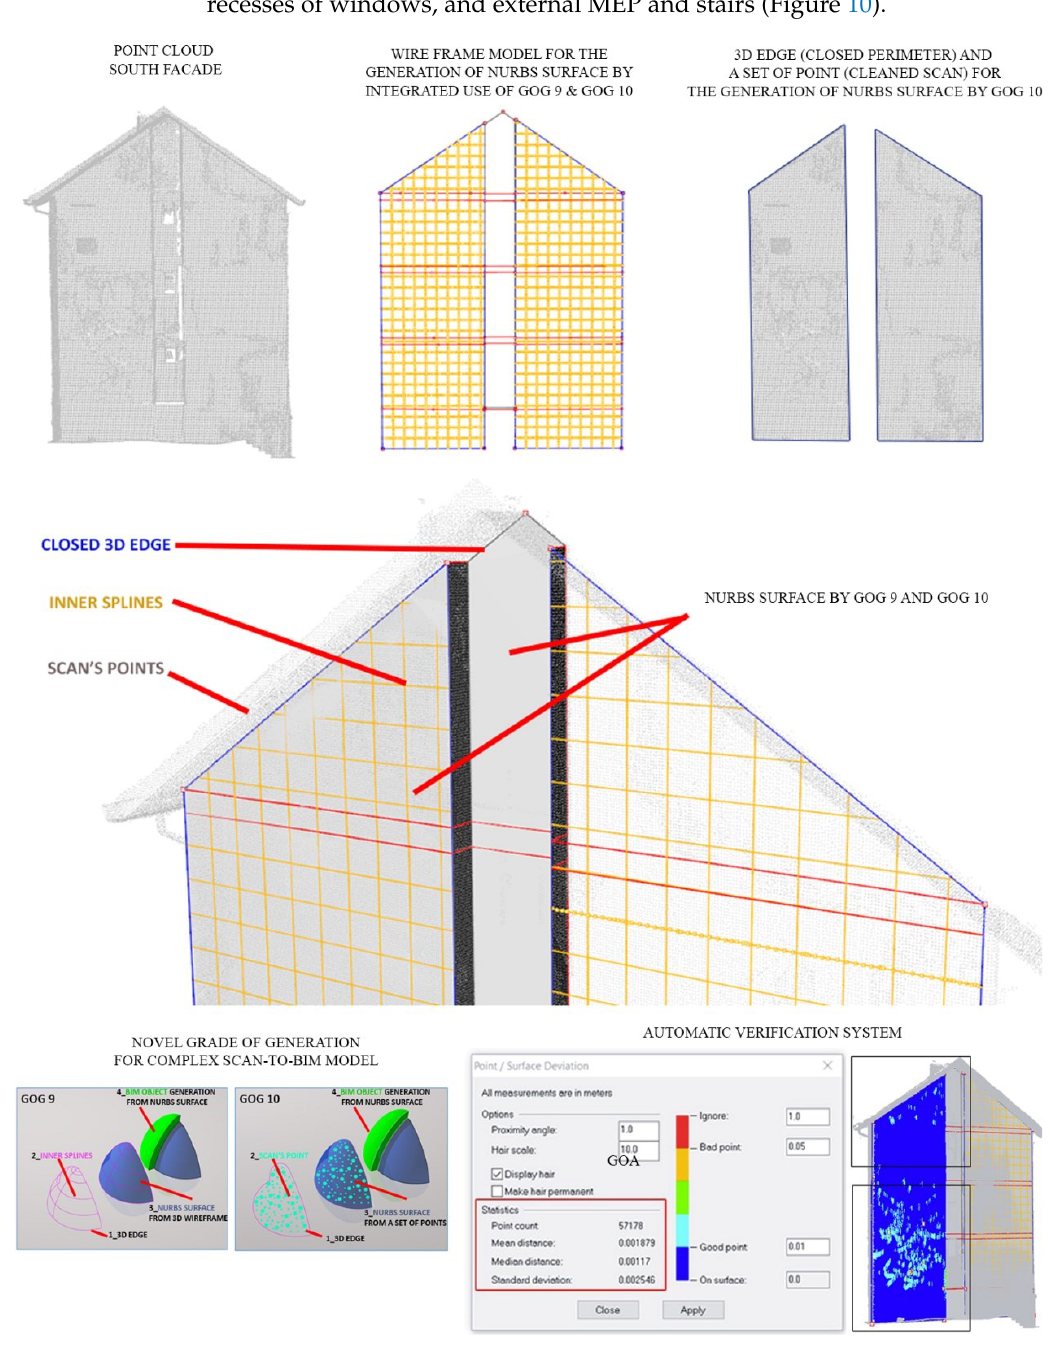
Figure 10. Application of GOG 10. The GOA of each building façade is around 2.5 mm.